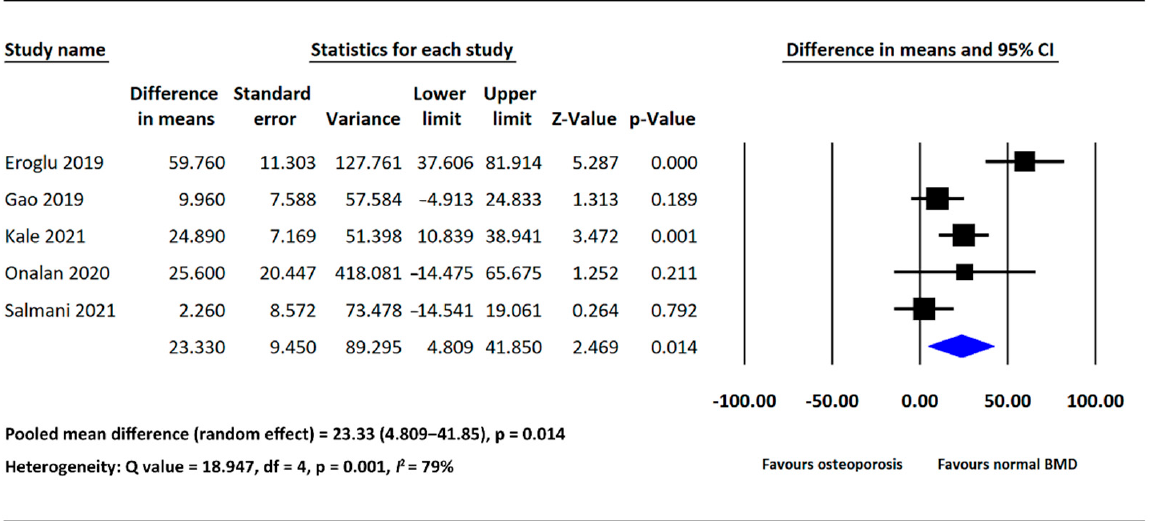
Figure 4. Forest plot of the mean difference in PLR between the osteoporosis and normal BMD groups [17–19,21,22].